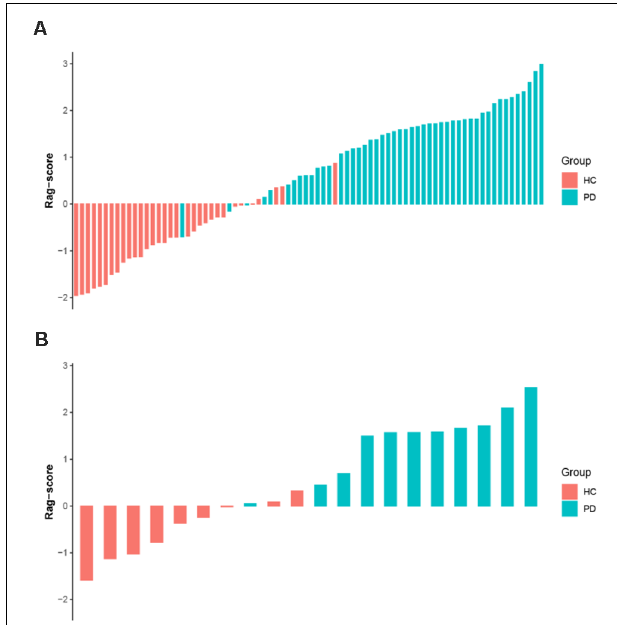
FIGURE 5 | The Rag-score for each subject in the primary (A) and validation (B) sets. Red bars represent the HC group and blue bars represent the PD group. The greater the score, the more likely it is to be PD. Rag-scores , radiomic signature scores; HC , healthy control; PD , Parkinson’s disease.